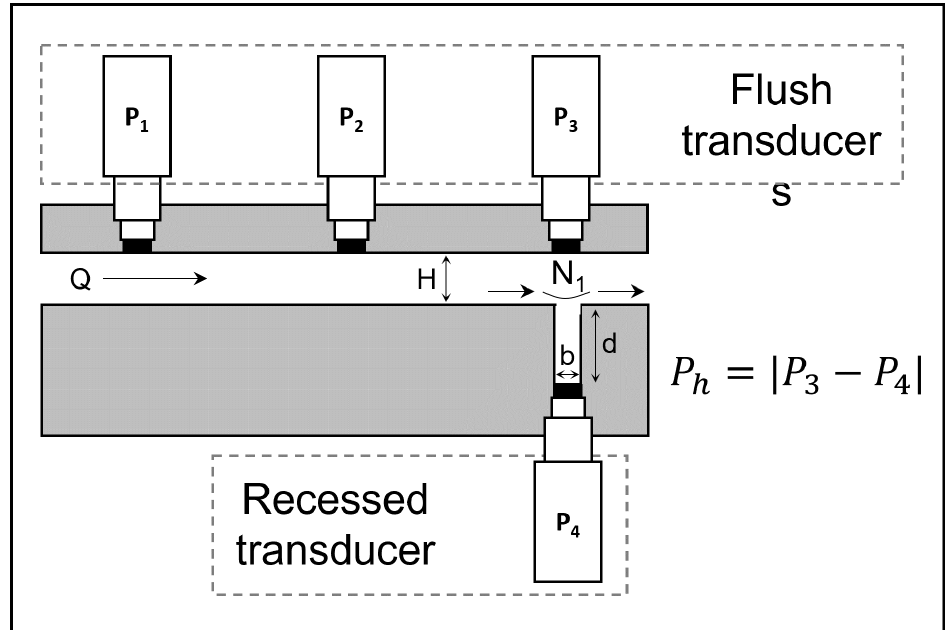
Figure 3. Representation of the position of the recessed transducer for the measurement of the first normal stress difference ( N 1 ) based on the hole pressure